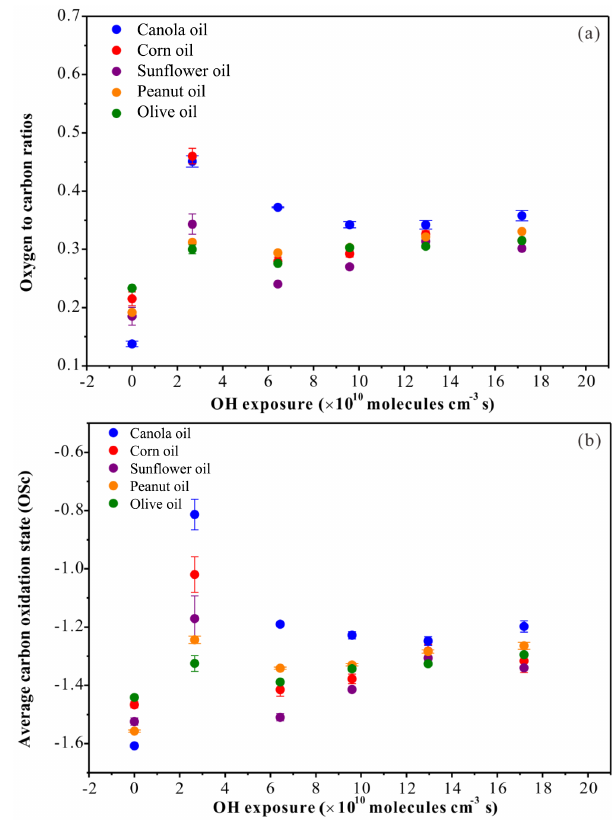
Figure 7. Evolution of (a) oxygen to carbon (O : C) molar ratios and (b) average carbon oxidation state (OS c ) as a function of OH exposure during the aging of gas-phase emissions from different heated cooking oils, with error bars indicating standard error. Data at [OH] = 0 represent POA from cooking